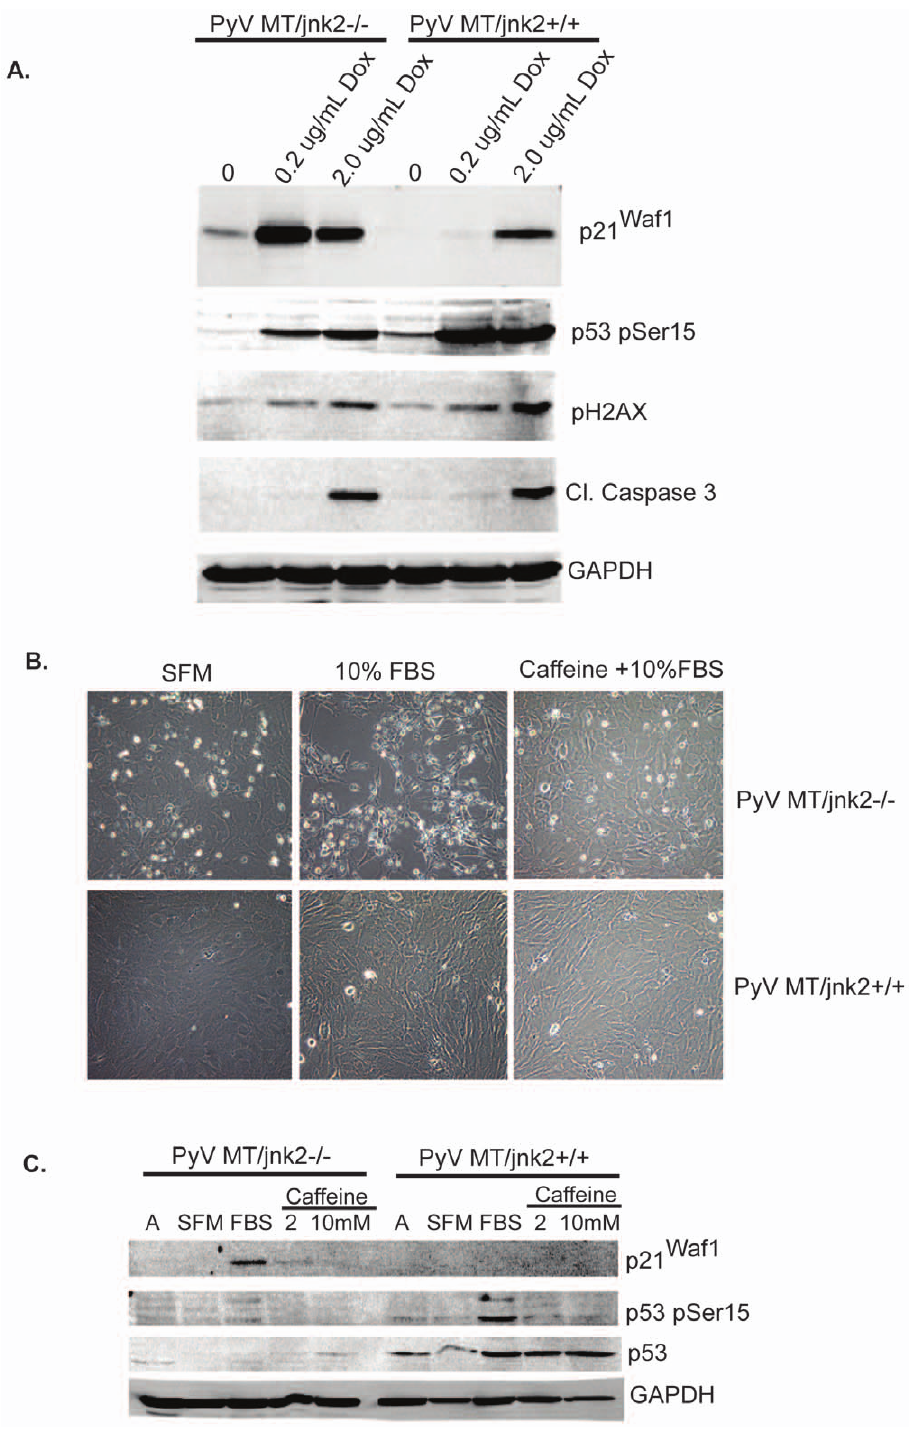
Figure 6. PyV MT/ jnk2 2 / 2 cellular response is specific to replication and reversed by ATM/ATR inhibitor caffeine. A ). PyVMT/ jnk2 + / + and PyVMT/ jnk2 2 / 2 cells were treated with doxorubicin at the indicated concentrations for 18 hours and then lysed. Expression of p21 Waf1 , p-p53 (Ser15), pH2AX (Ser139), and cleaved caspase 3 were evaluated using western blot analysis. GAPDH was used to compare even loading amongst samples; B ). Cells were treated as described in A). except caffeine 2 mM was added as indicated; C ). Cells were treated as described in A). except caffeine 2 and 10 mM were added as indicated. Expression of p21 Waf1 , p-p53 (Ser 15), and p53 were evaluated using western blot analysis. GAPDH was used to compare even loading amongst samples.